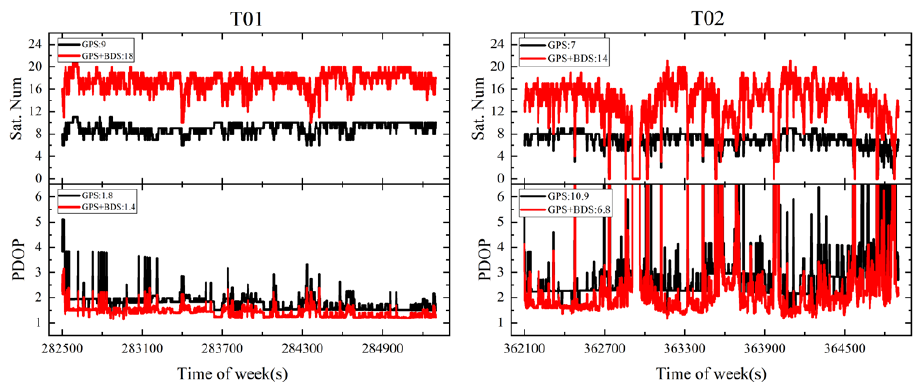
Figure 5. Satellite number of GPS/BDS and PDOP for T01 (left panel) and T02 (right panel), respectively. Considering the high-precision ionospheric and tropospheric delay augmentation and ambiguity resolution to support PPP-RTK, the measurement data of seven reference stations as distributed in Figure 6 were also collected. They were processed to generate high-precision atmospheric delay corrections and UPD products. The average distance between the seven reference stations is 40 km and the green trajectories are the trajectories of the two tests as shown in Figure 3.